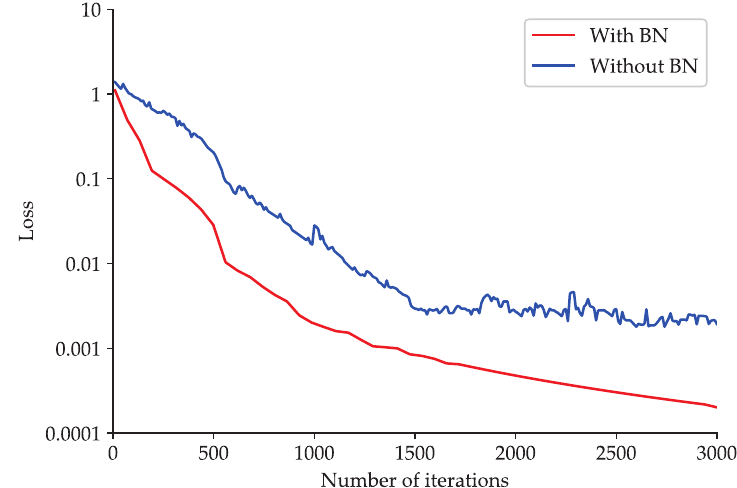
Figure 12. Loss function curve obtained during the training processes of the improved 2D LeNet-5 network with BN and that without BN.